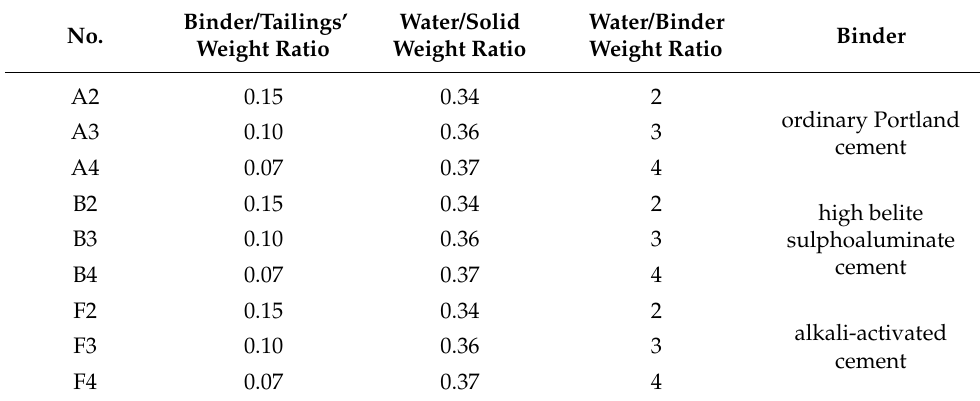
Table 2. Material proportions of the tungsten-ore tailings’ mixtures. Binder/Tailings’ Water/Solid Water/Binder Binder No. Weight Ratio Weight Ratio Weight Ratio A2 0.15 0.34 2 ordinary Portland cementA3 0.10 0.36 3 A4 0.07 0.37 4 0.15 0.34 2 high belite sulphoaluminate cementB3 0.10 0.36 0.15 0.34 alkali-activated cementF3 0.10 0.36 F4 0.07 0.37